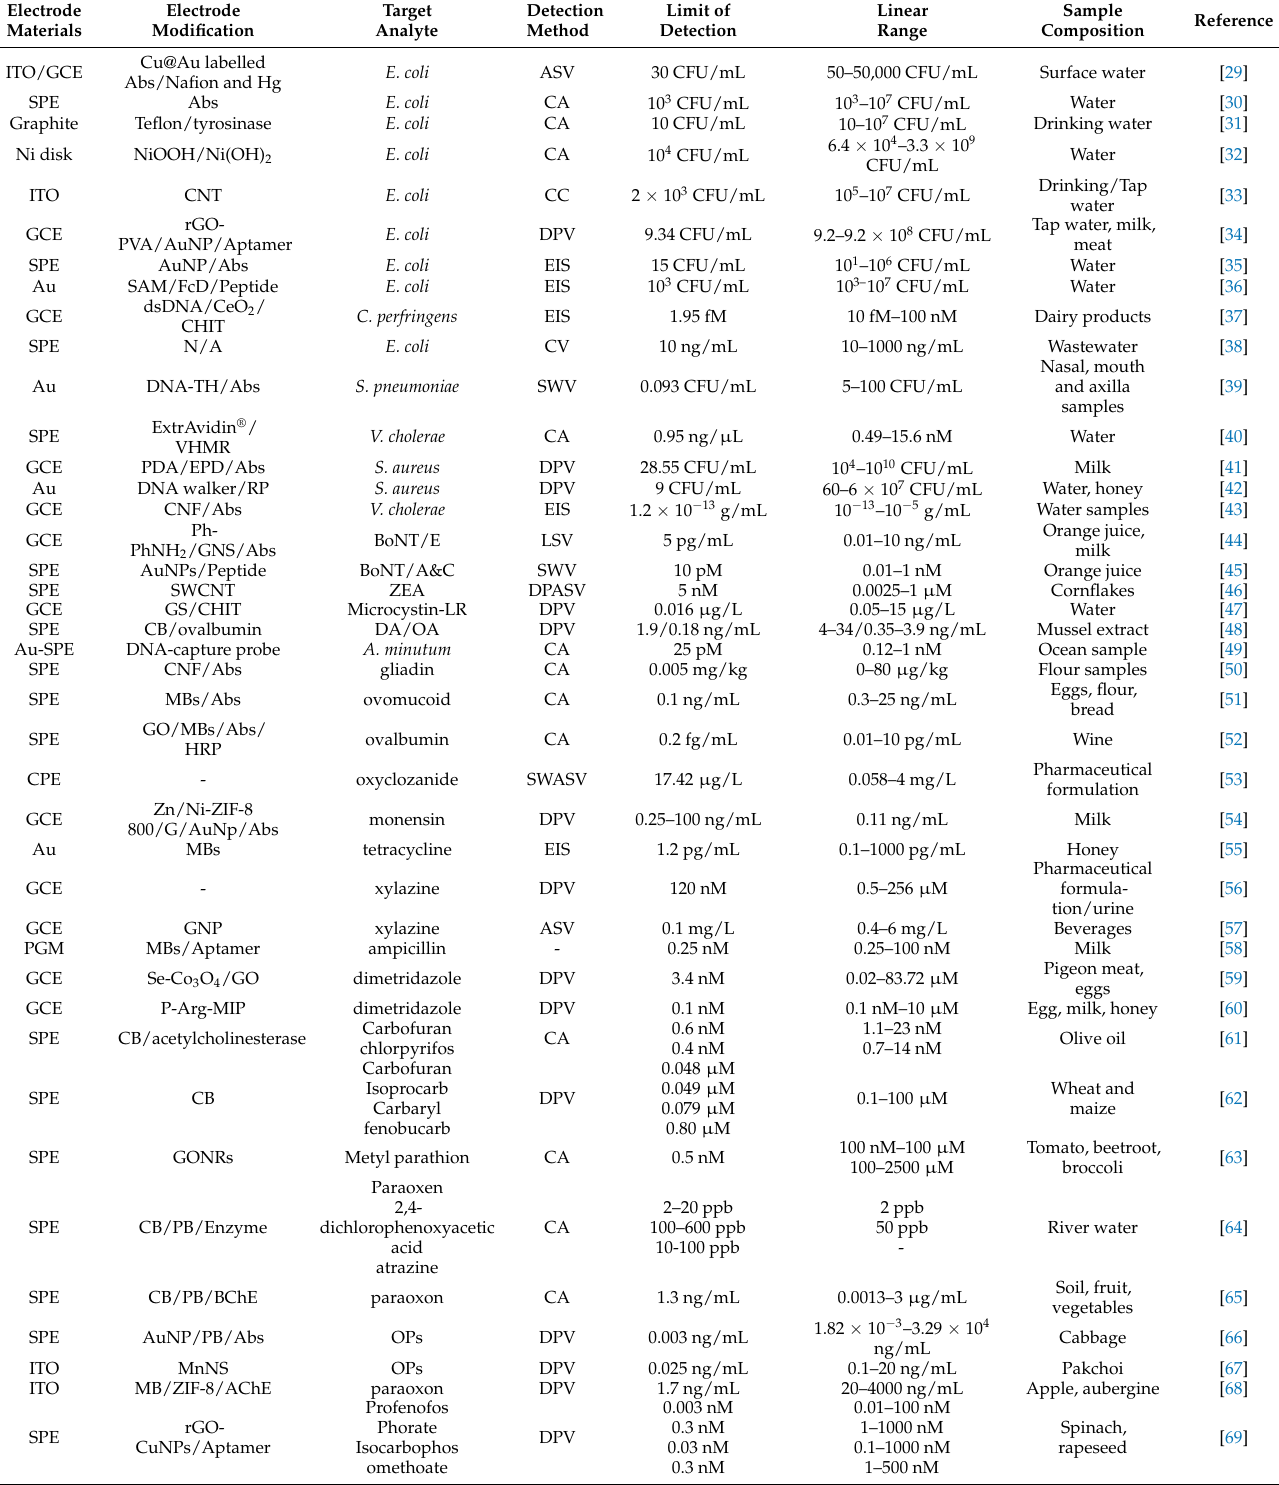
Table 1. An overview comparing the different electrodes and their modifications for detection of different analytes relevant to food safety alongside the limits of detection and linear ranges achieved and the composition of samples that were